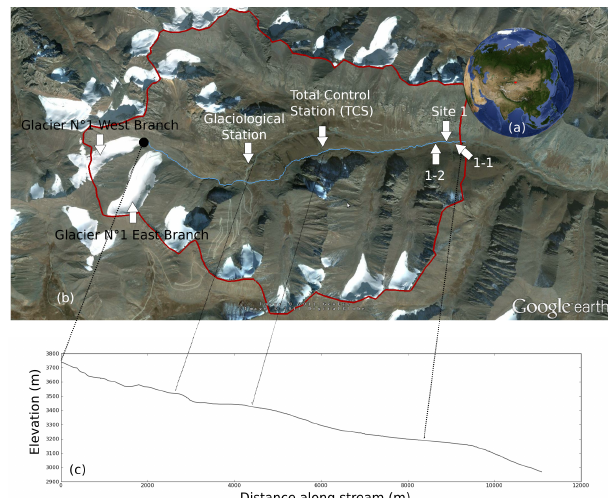
Fig. 1. Location map: (a) location of Tianshan and survey site, (b) satellite image and map of the Urumqi River drainage showing the sampling reach (Google Earth kml file available as Supplement), (c) kinematic GPS along the stream profile of the Urumqi